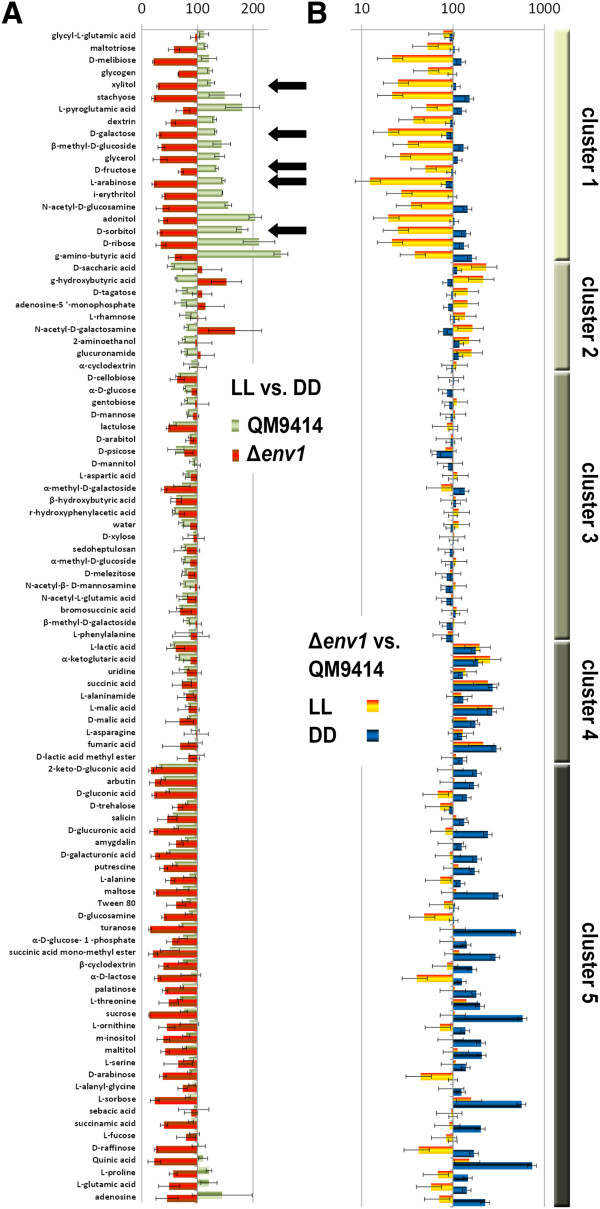
BIOLOG analysis of growth of QM9414 and env1PAS- in light and darkness. Strains were grown for 72 hours on 96 different carbon sources
[23]. Hierarchical cluster analysis was performed using HCE 3.5 with default settings. Standard deviations shown result from three biological replicates. Values are represented as percent. LL means constant light, DD means constant darkness.